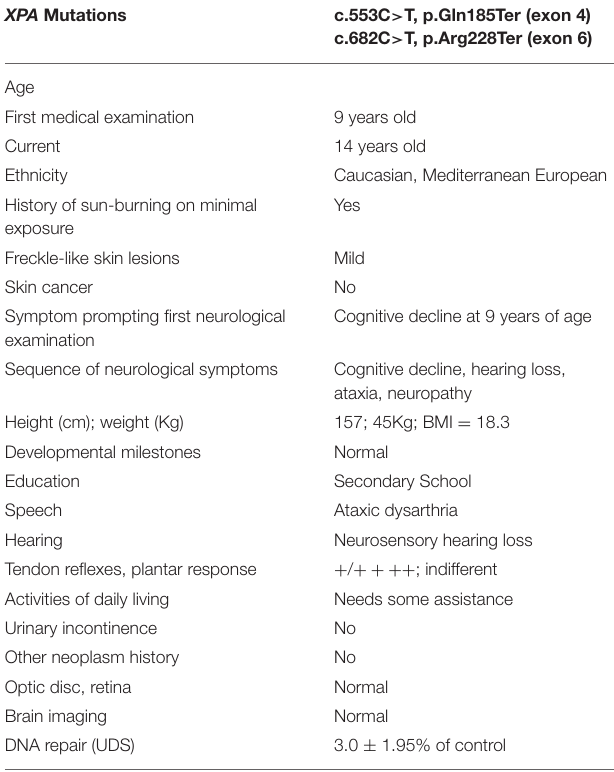
TABLE 1 | XP-A patient’s molecular, clinical and neurological